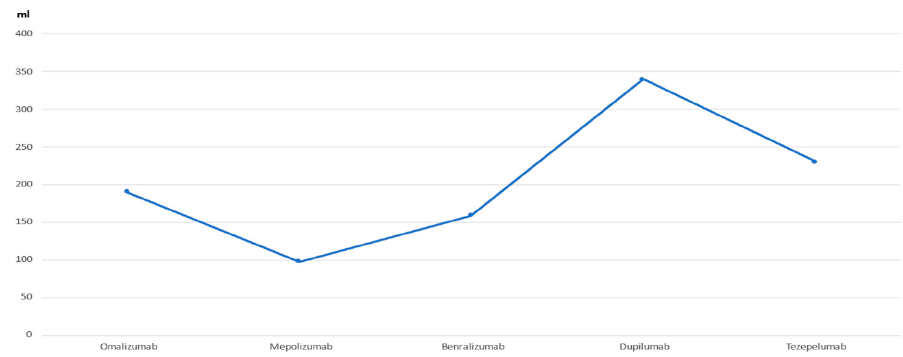
Figure 3. FEV 1 improvement. FEV 1 : forced expiratory volume in the first second.